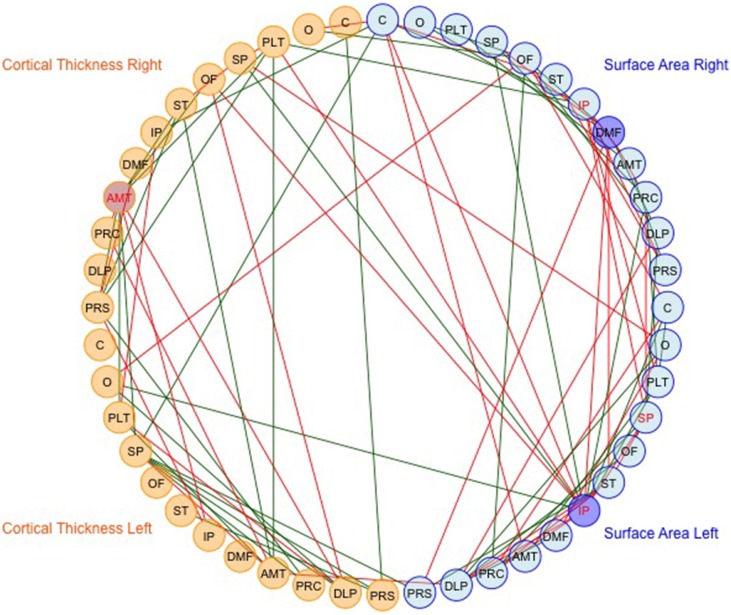
The observed data for SA and CT of the parcellations combined. Table 1 presents the parcellation abbreviations for reference. Edges represent genetic correlations where p < 0.05. Red edges denote negative genetic correlations, and green edges denote positive genetic correlations. The right side of the diagram depicts SA cluster nodes (in blue) and the left side depicts CT cluster nodes (in orange). Darker shaded circles denote parcellations with the highest nodal degree within SA or CT, and red lettering denotes parcellations with highest nodal degree across all 48 parcellations. The bilaterally symmetrical CT correlations are sparser than bilateral SA correlations.